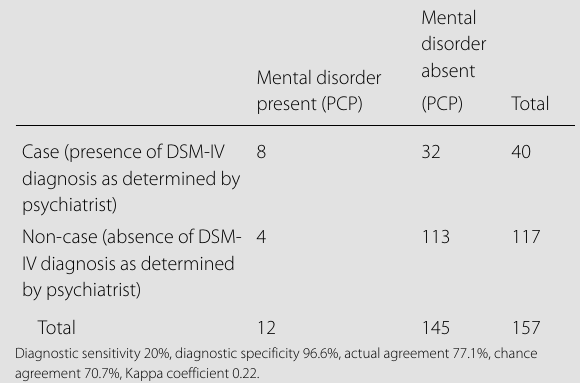
Table III. Comparison of routine clinical diagnoses of mental disorder by PCPs and DSM-IV diagnoses by psychiatrists